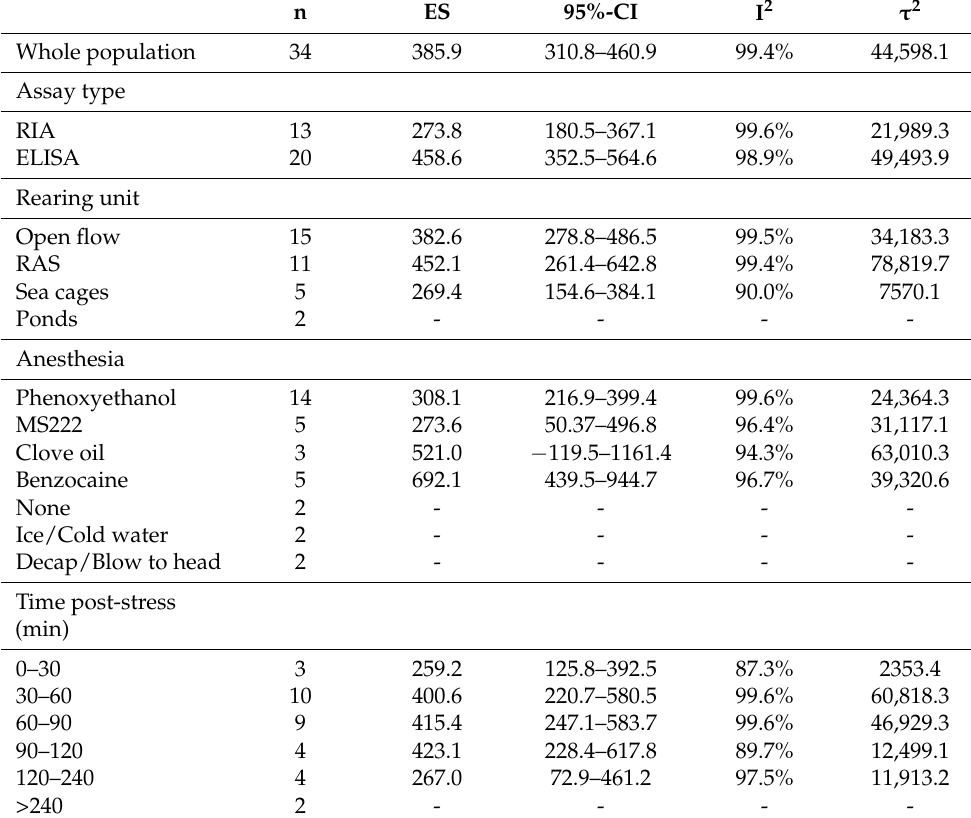
Table 4. Results of the meta-analysis regarding post-stress cortisol levels, including subgroup analysis. ES: effect size; 95%-CI: 95% confidence intervals; I 2 : Higgin’s and Thompson’s between- study heterogeneity statistic; τ 2 : heterogeneity variance.